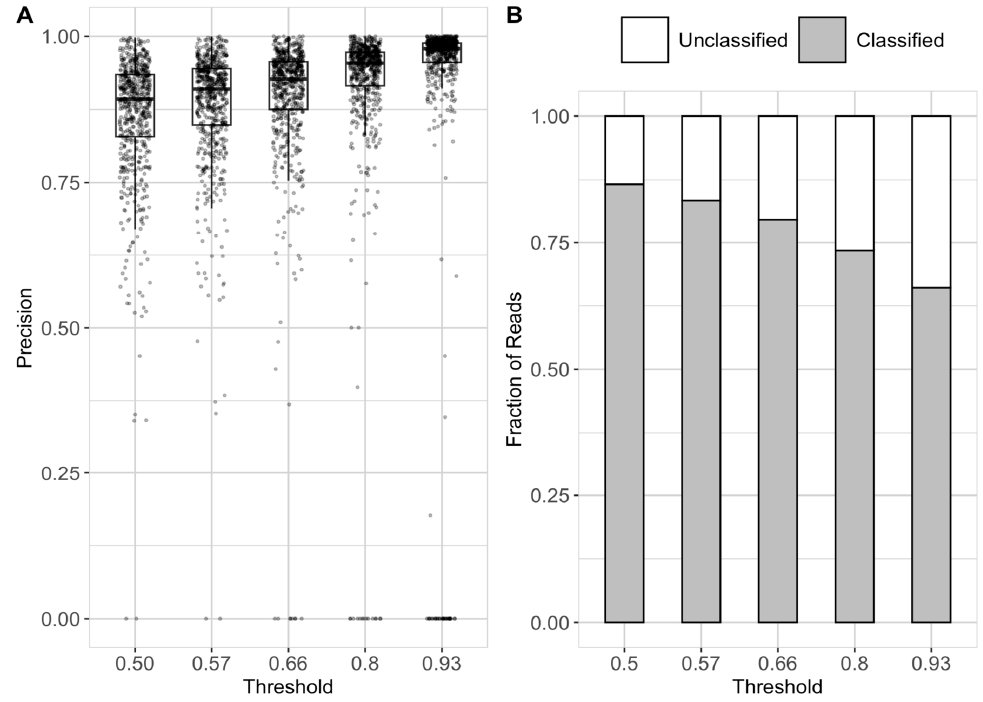
Figure 5. DL-TODA precision for the 639 species in the testing set ( A ) and fraction of unclassified and classified reads at the species level ( B ) at different decision thresholds (0.5, 0.57, 0.66, 0.8 and 0.93).